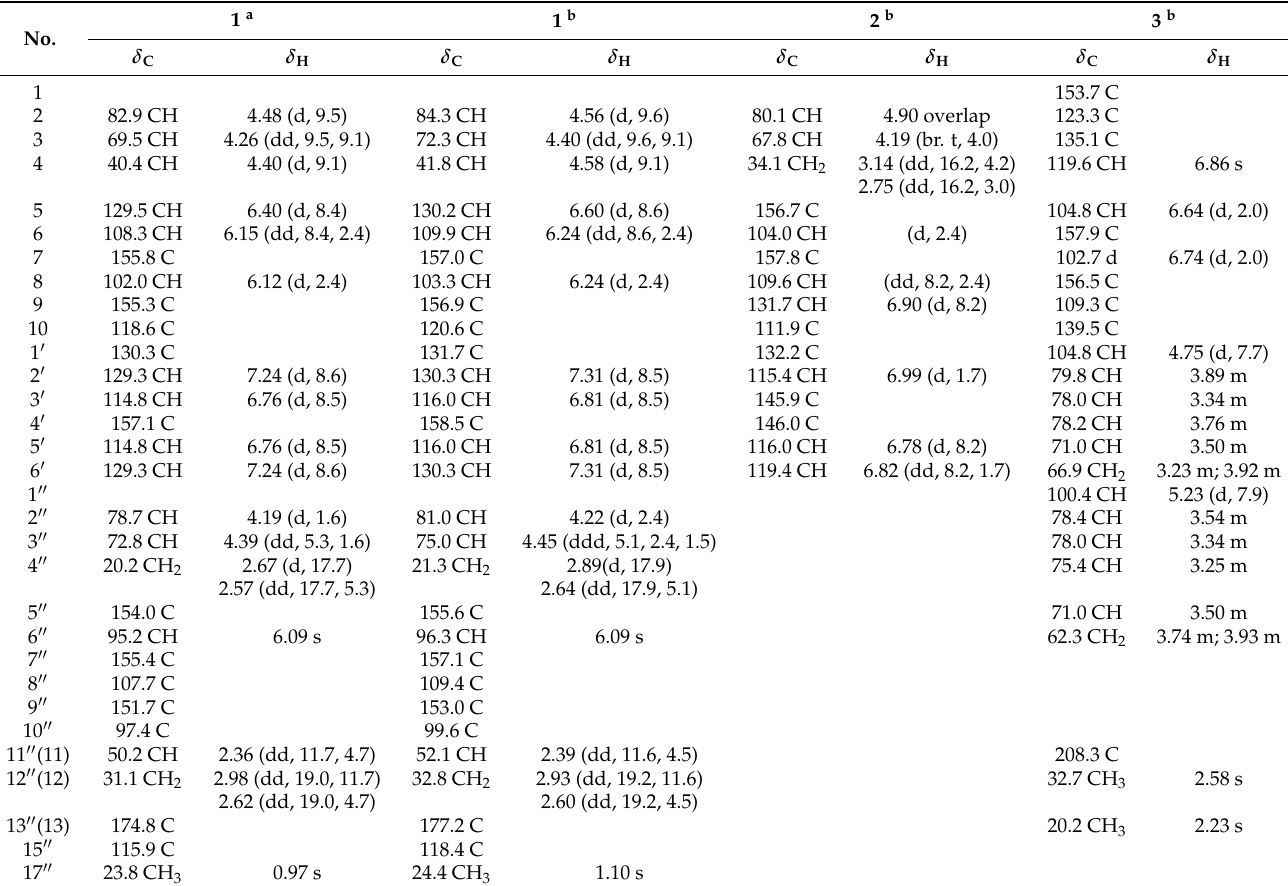
Table 1. 1 H (500 Hz) and 13 C (125 Hz) NMR spectroscopic data of 1 – 3 ( δ in ppm, J in Hz within parentheses).